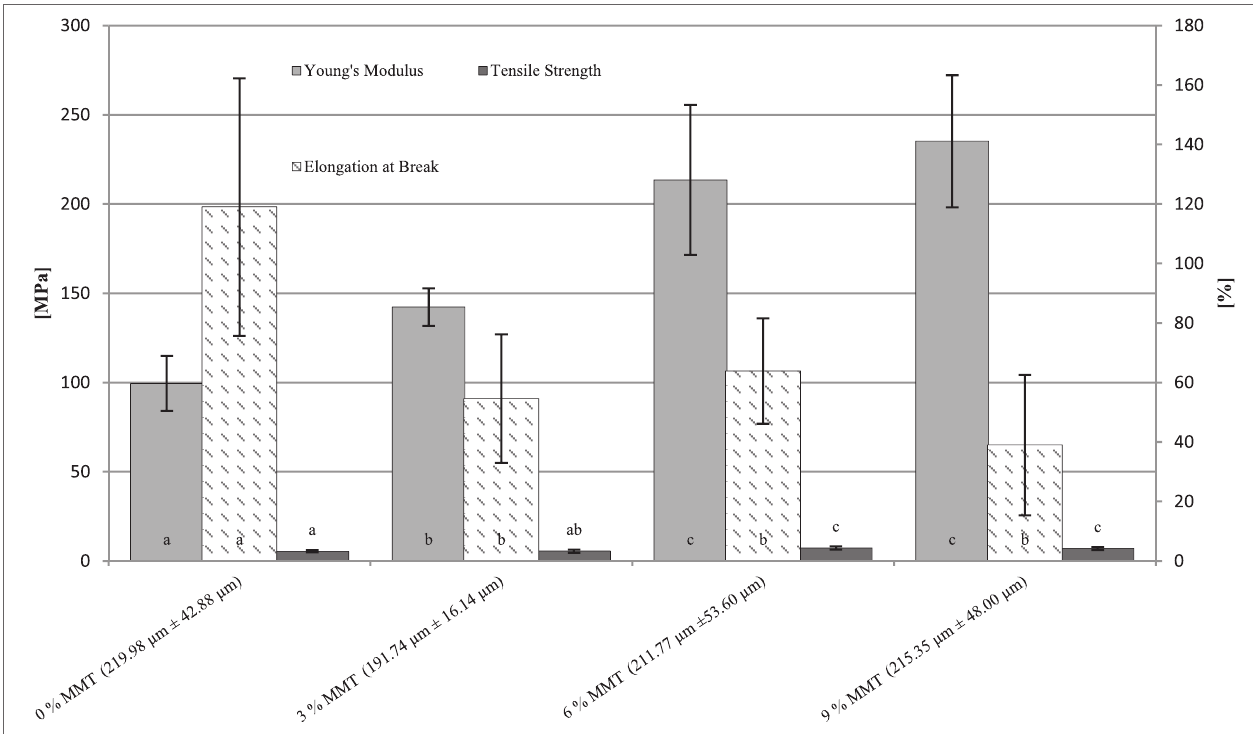
FigUre 5 | Young’s modulus, tensile strength, and elongation at break depending on different montmorillonite (MMT) nanofiller concentrations in whey protein isolate (WPI)-based [15% (w/w) WPI, 100.00% (w/w protein) glycerol] nanocomposite cast films. Film thicknesses (mean ± SD) refer to the elongation at break measurement. Different letters indicate significant differences for each sample set ( p ≤